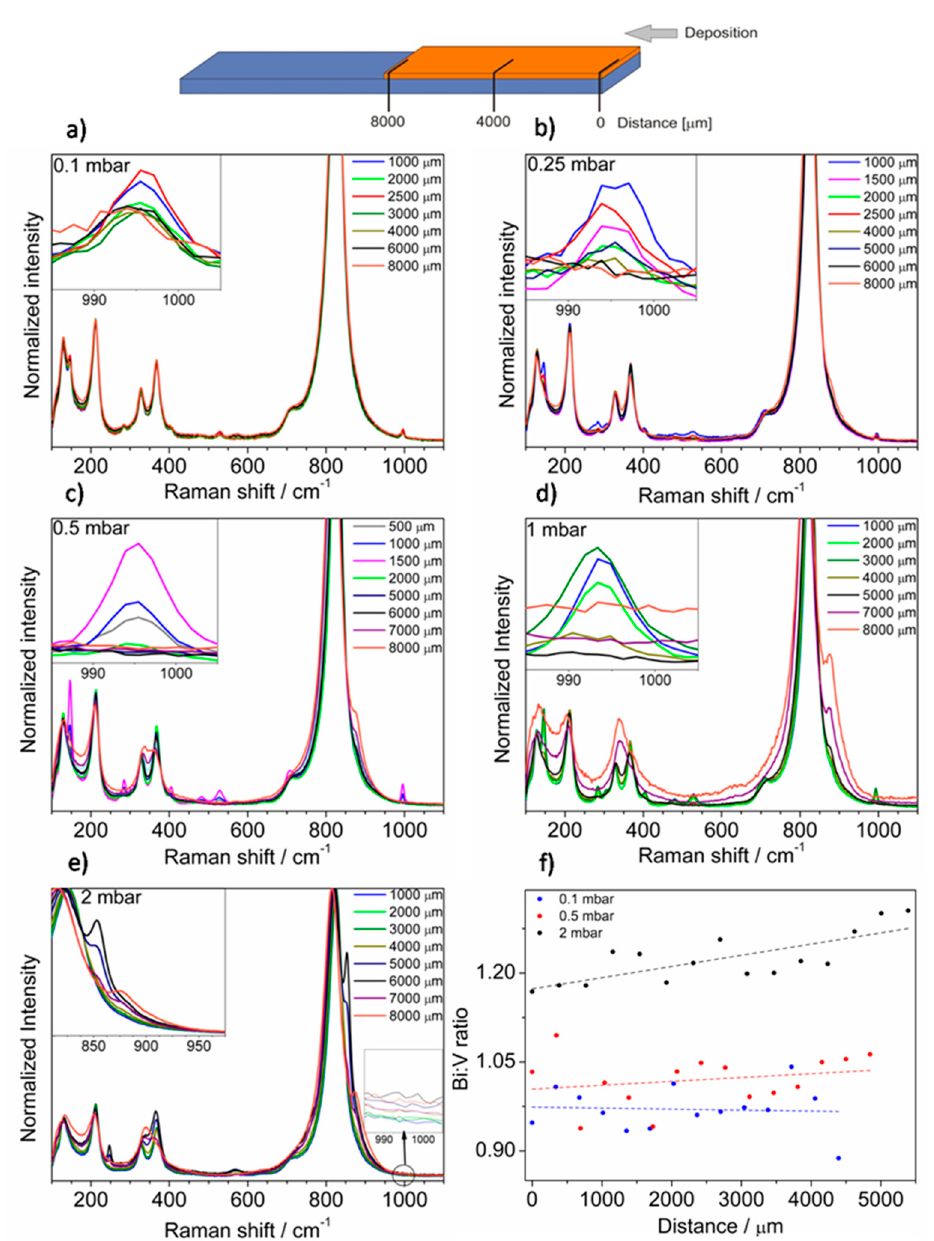
Figure 4. ( a – e ) Raman spectra of FTO / BiVO 4 samples deposited under di ff erent pressures measured at di ff erent spots and ( f ) Bi:V ratio estimated on the basis of EDX measurements.